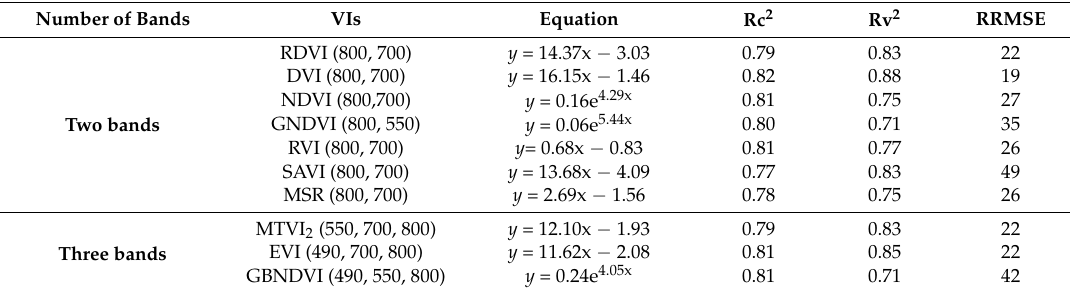
Table 6. Quantitative relationship between LAI and VIs from Field Spec 4